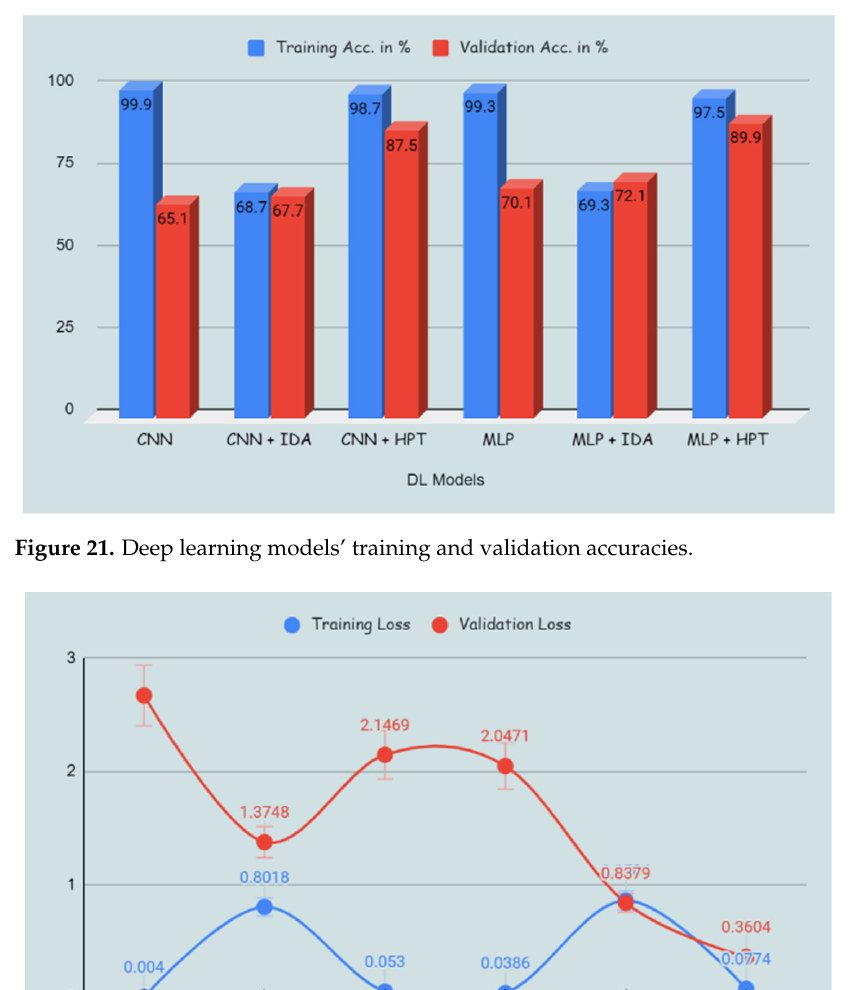
Figure 20. Transfer learning models’ training and validation losses.